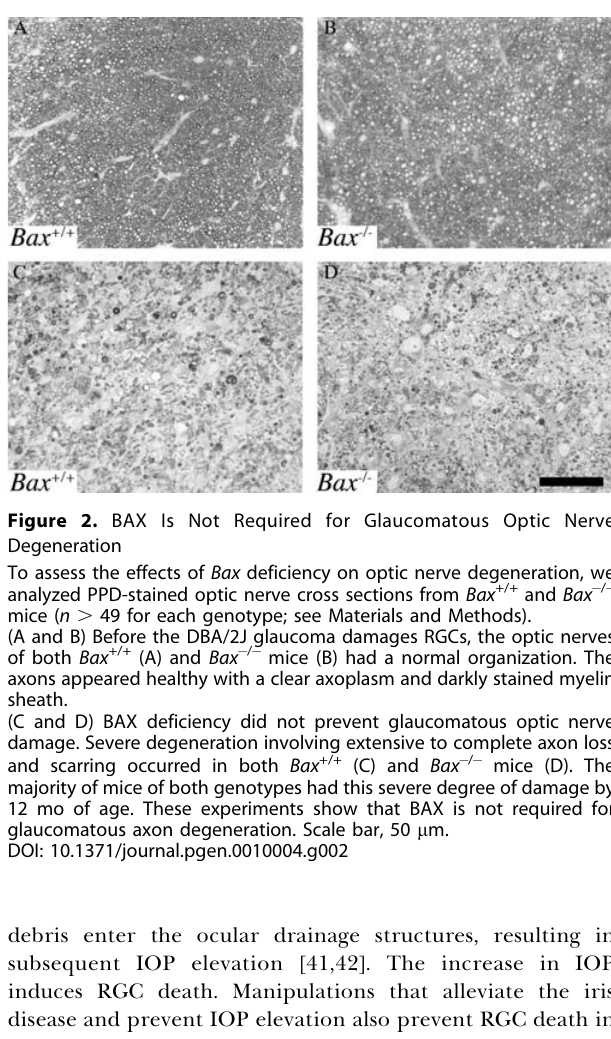
(Figure 4). In contrast, the IOPs of Bax +/ (cid:1) and Bax +/+ mice were not different. Because of the lower IOP in Bax (cid:1) / (cid:1) mice, found no differences (average 6 SEM, number of eyes